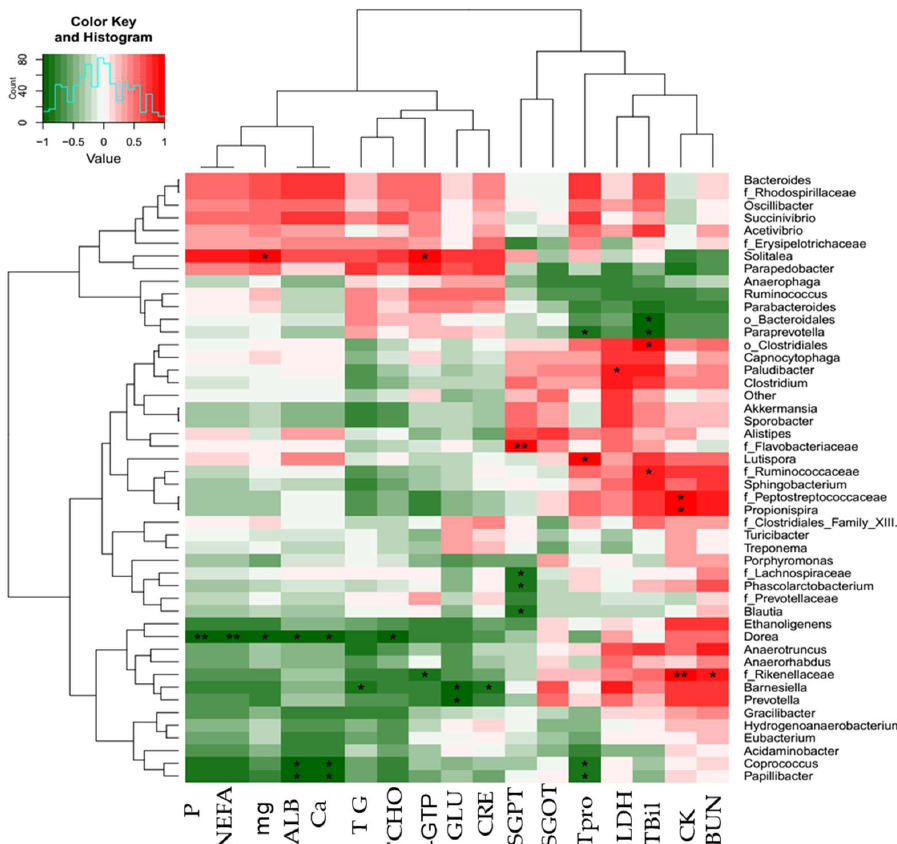
Figure 4. The correlation between genus-level microbiota and serum metabolic profiles in experimental steers represented by a heatmap: Albumin (ALB), calcium (CA), creatinine kinase (CK), creatinine (CRE), gamma-glutamyl transferase ( γ -GTP), glucose (GLU), serum glutamate oxaloacetate transferase (SGOT), serum glutamate pyruvate transferase (SGPT), lactate dehydrogenase (LDH), blood urea nitrogen (BUN), total bilirubin (T-Bil), total protein (TPro); minerals such as calcium (ca), phosphate (p), magnesium (mg); and lipid profiles including total cholesterol (T-CHO), triglycerides (TG), and non-esterified fatty acids (NEFA)). * Indicates statistical significant difference between grazing and housing steers at 0.05 level. ** Indicates statistical significant difference between grazing and housing steers at 0.001 level